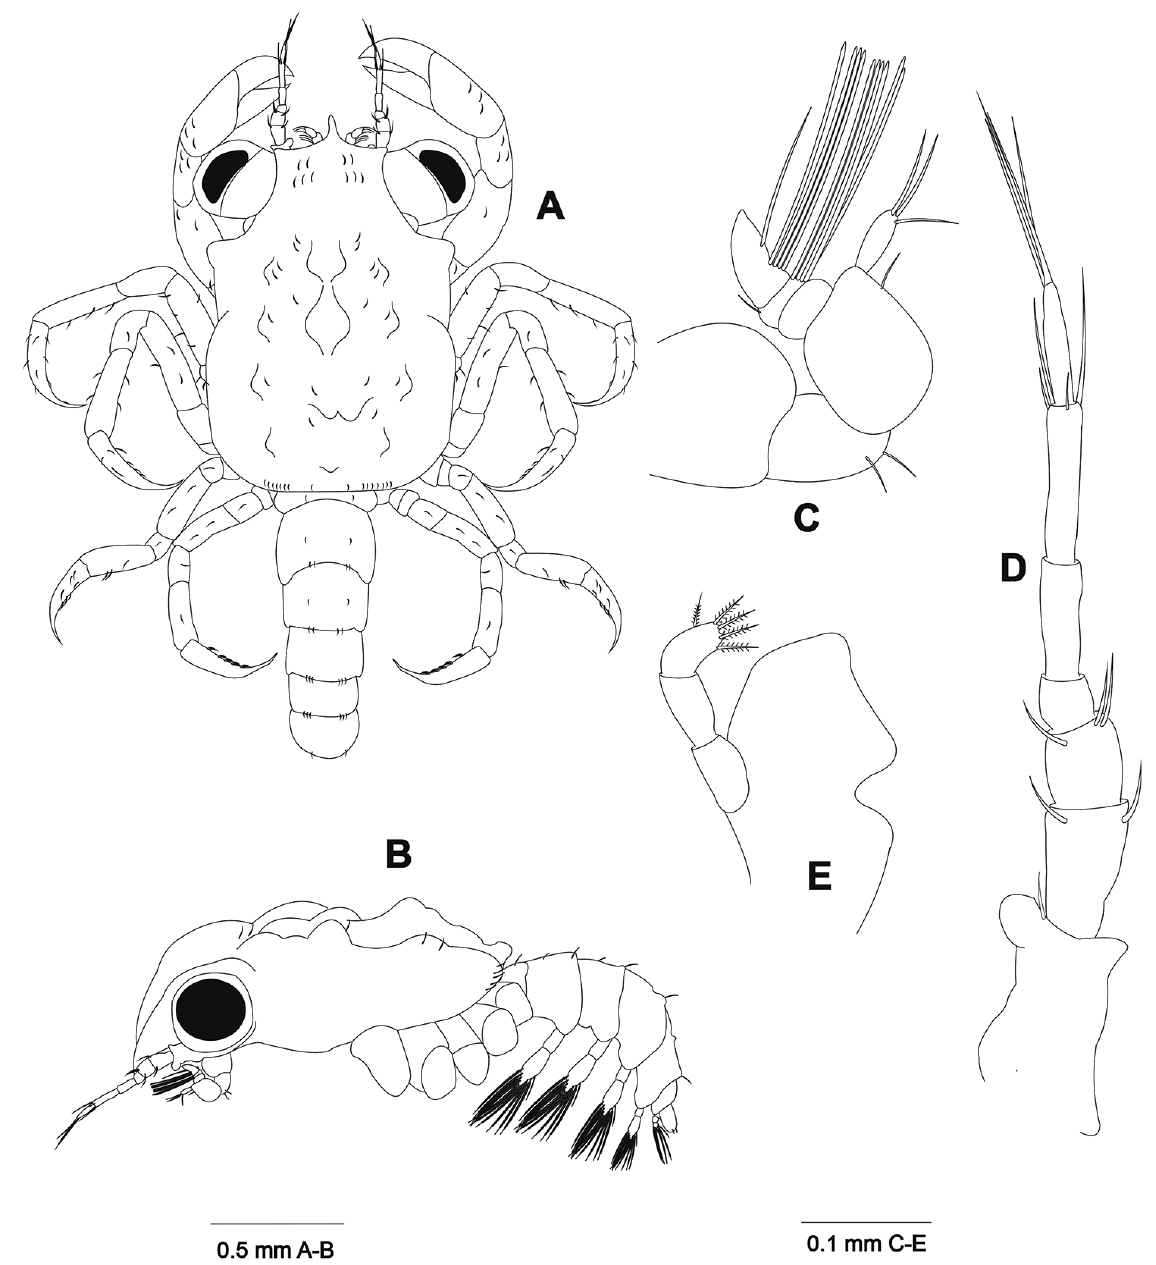
Figure 5. Libinia rhomboidea megalopa. ( A ) Dorsal view; ( B ) lateral view; ( C ) antennule; ( D ) antenna; ( E )